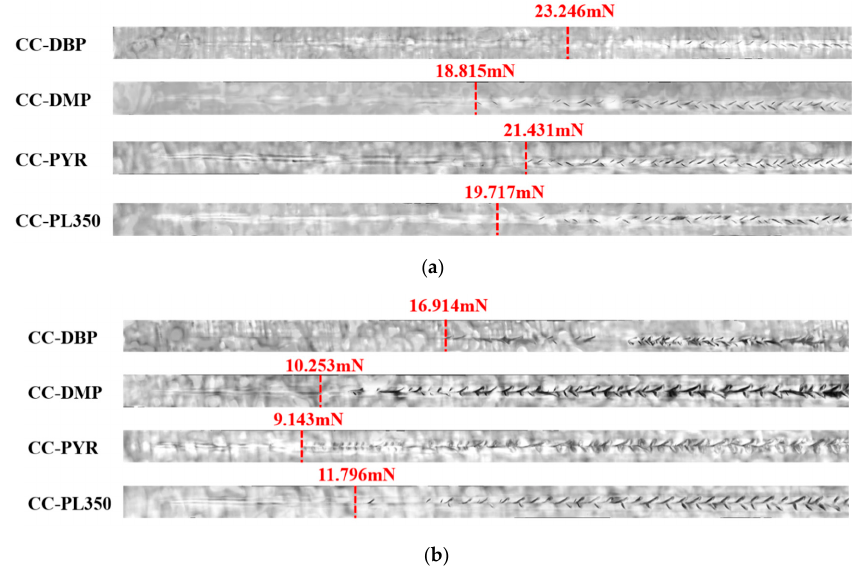
Figure 7. Scratch depth profiles and critical loads (Lc1) of clearcoat films cured at ( a ) 150 °C and ( b ) 120